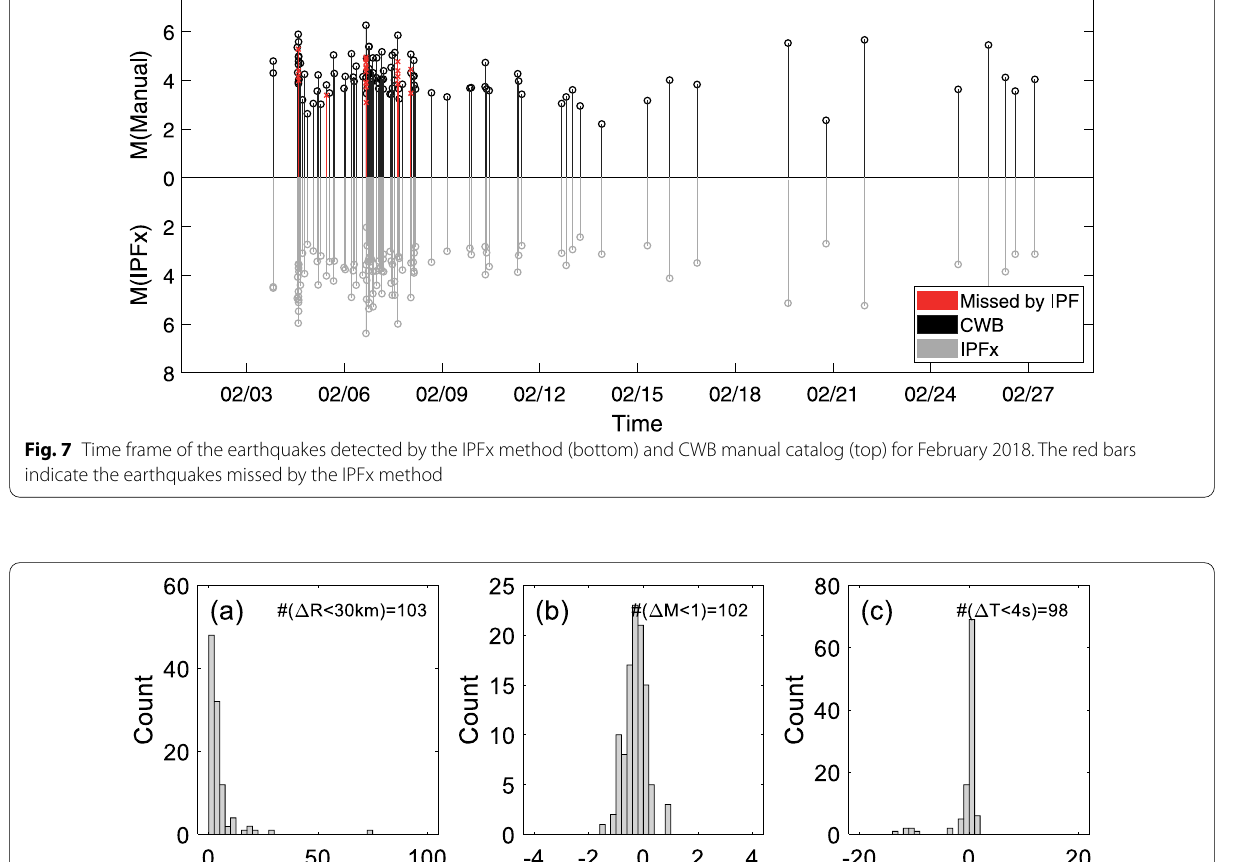
4. A comparison of the IPFx results at ≥